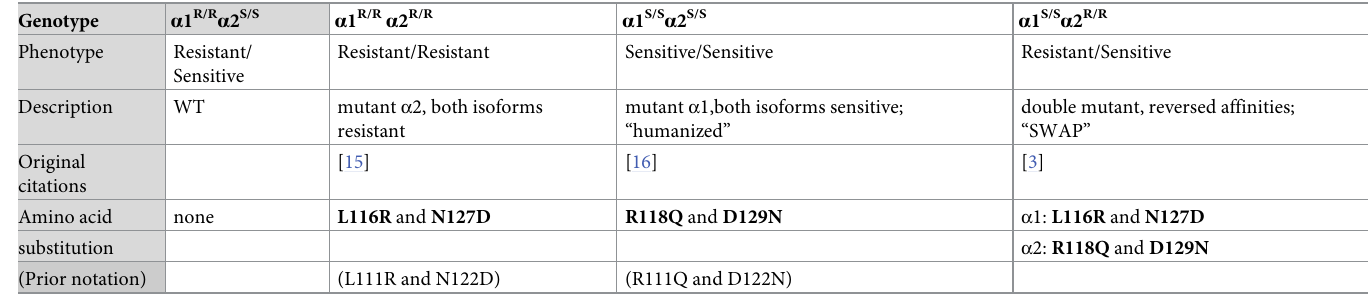
Table 1. Homozygous mouse models obtained by breeding mice with α 1 S and/or α 2 R mutations.